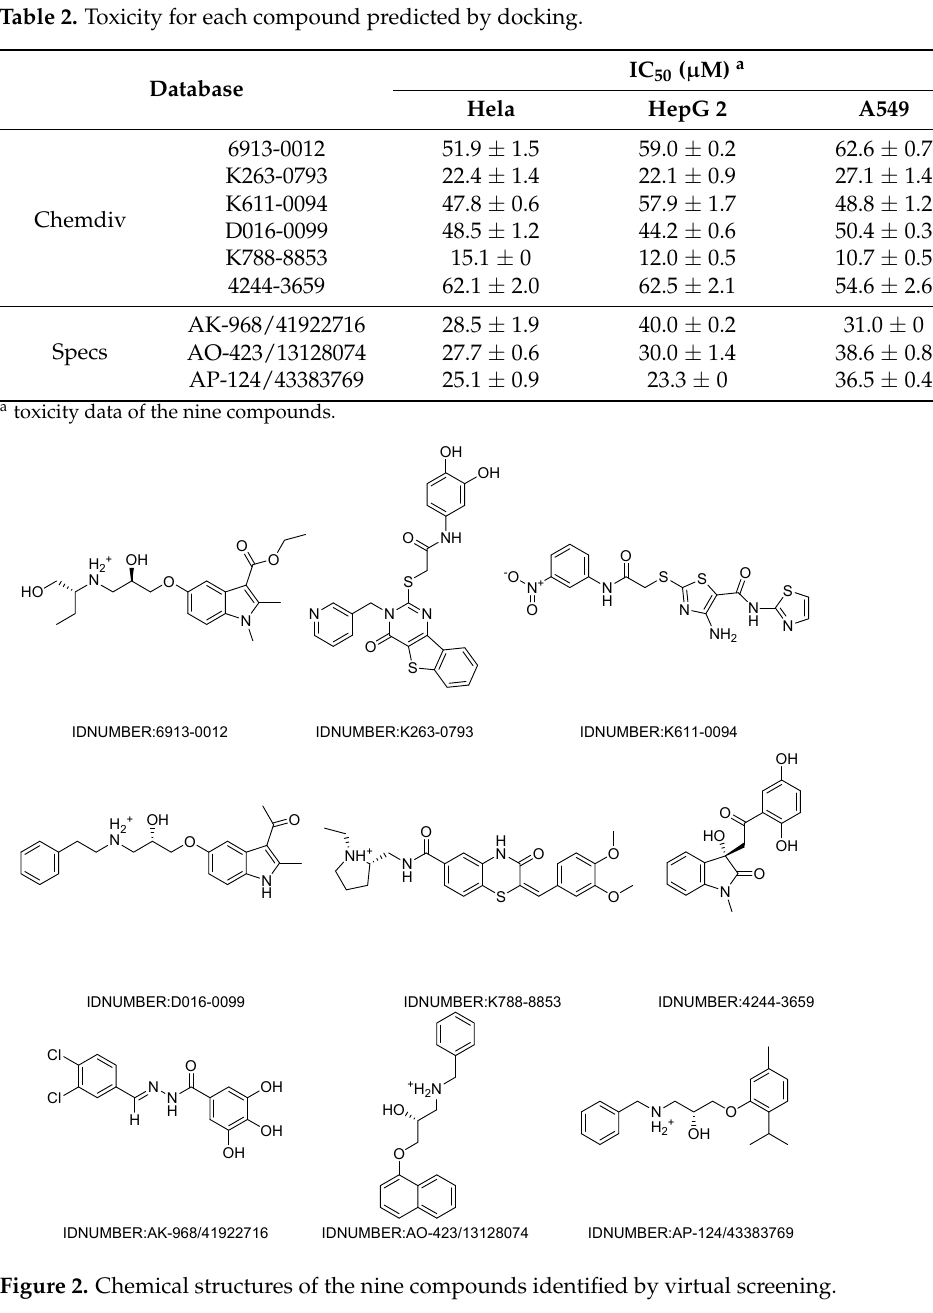
Figure 2. C hemical structures of the nine compounds identified by virtual screening. Figure 2. Chemical structures of the nine compounds identified by virtual Table 1. Information of nine selected compounds.